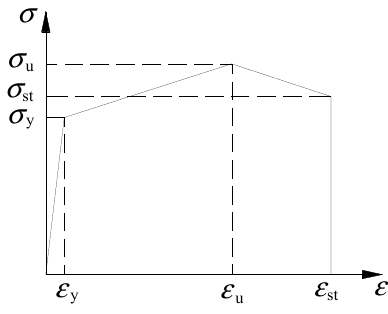
Figure 3. Stress-strain relationships: σ y and ε y are the yield stress and yield strain, respectively; σ u and ε u are the ultimate stress and ultimate strain, respectively; σ st and ε st are the failure stress and failure strain, respectively.